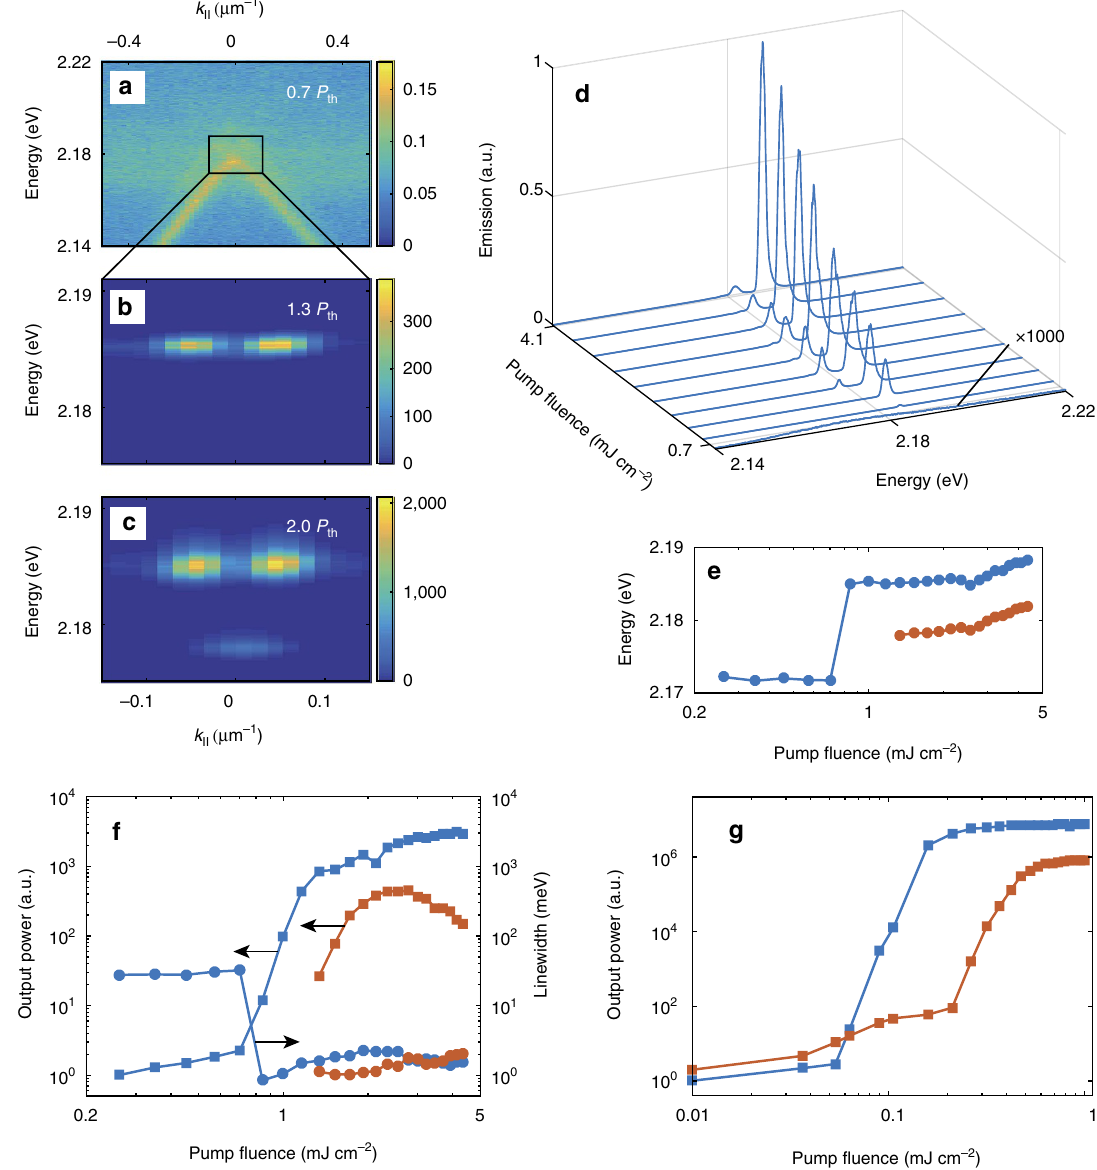
Figure 2 | Light emission below and above the lasing threshold. Measured emission intensities of a 100 (cid:2) 100( m m) 2 nanoparticle array (array periods